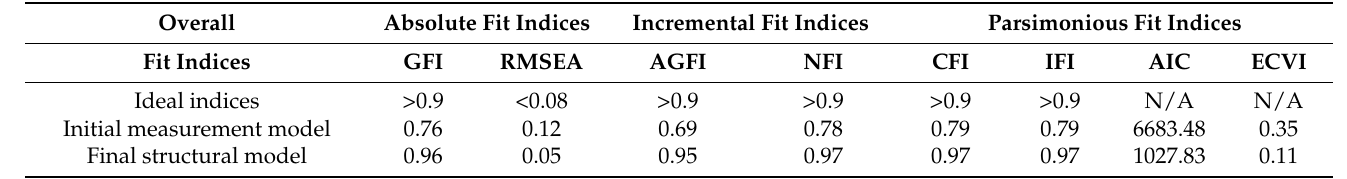
Table 5. Summary of the overall fit indices for the initial measurement model and final SEM